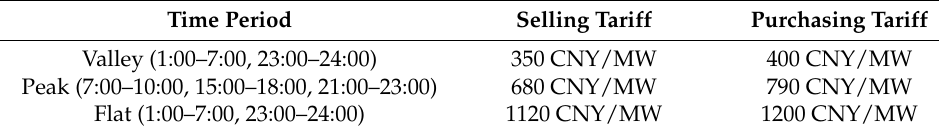
Table 2. Time-of-use tariff for microgrid